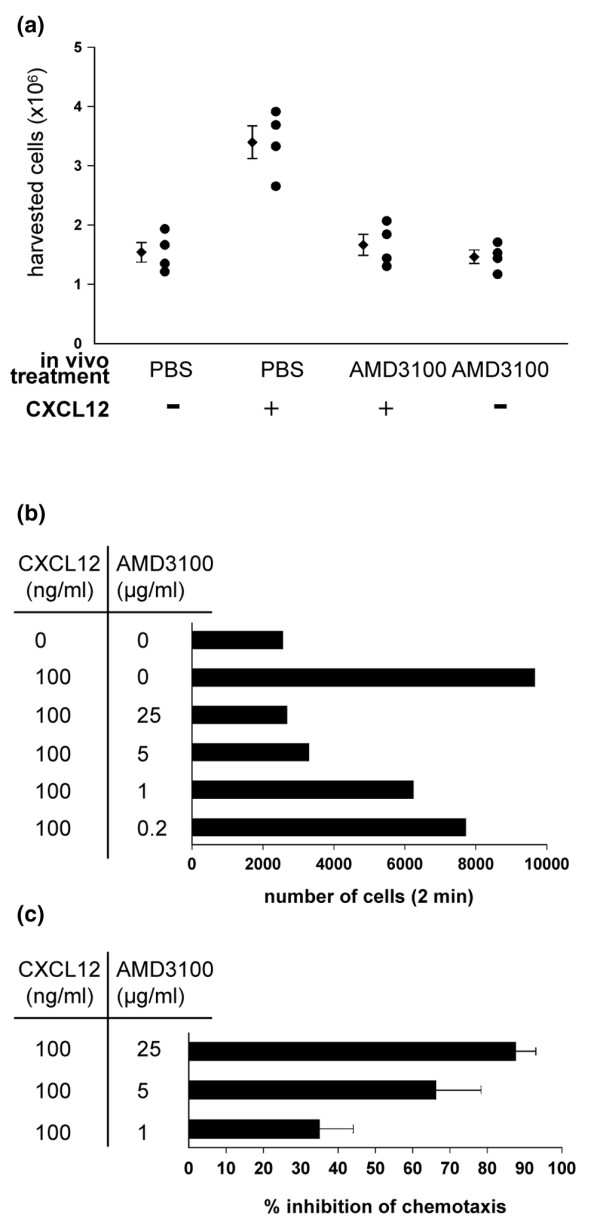
AMD3100 blocks CXCL12-elicited chemotaxis in vivo and in vitro. (a) Sixteen mice were immunized with collagen type II (CII) in complete Freund's adjuvant on day 0 and treated with AMD3100 or PBS in a similar way as described in the legend of Fig. 1. In vivo treatment is indicated along the X-axis. On the last day of treatment, a chemotactic assay was performed as described in Materials and methods. On that day, mice were injected with 2 μg of CXCL12 in 1 ml 0.9% NaCl (+) or 0.9% NaCl only (-) in a subcutaneous air pouch. Two hours after chemokine challenge, cells were washed out of the air pouch with 2 ml of PBS/FCS 2% and counted. Counts of the individual mice are shown (circles) and average ± standard error of the mean are indicated for each group (diamonds). (b,c) Dose-dependent inhibition by AMD3100 of CXCL12-elicited chemotaxis on total splenocytes. On day 21 post immunization with CII in complete Freund's adjuvant, spleens of three mice were pooled and a splenocyte suspension was prepared. Cell samples were pre-incubated for 10 minutes with AMD3100 at the indicated concentrations. Then, 5-μm filter inserts were loaded with 106 cells and transferred to a 24-well plate containing 100 ng/ml human CXCL12 in 600μl of buffer per well. After 3.5 h of incubation, the membrane inserts were removed and the cells in the wells were collected and counted by flow cytometry. The numbers of migrated cells of one representative experiment are shown in (b). (c) The experiment was confirmed by three additional experiments and the data of the experiments were pooled and represented as the percentage inhibition ± standard error of the mean of CXCL12-elicited chemotaxis by the indicated concentrations of AMD3100.